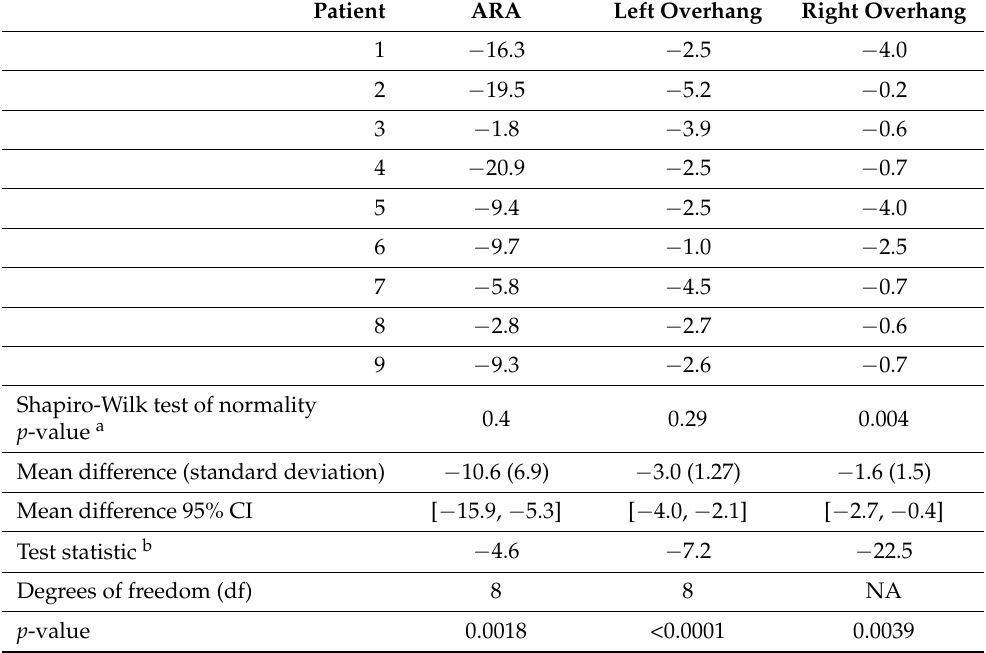
Differences between post- and pre-treatment measurements (negative values denote